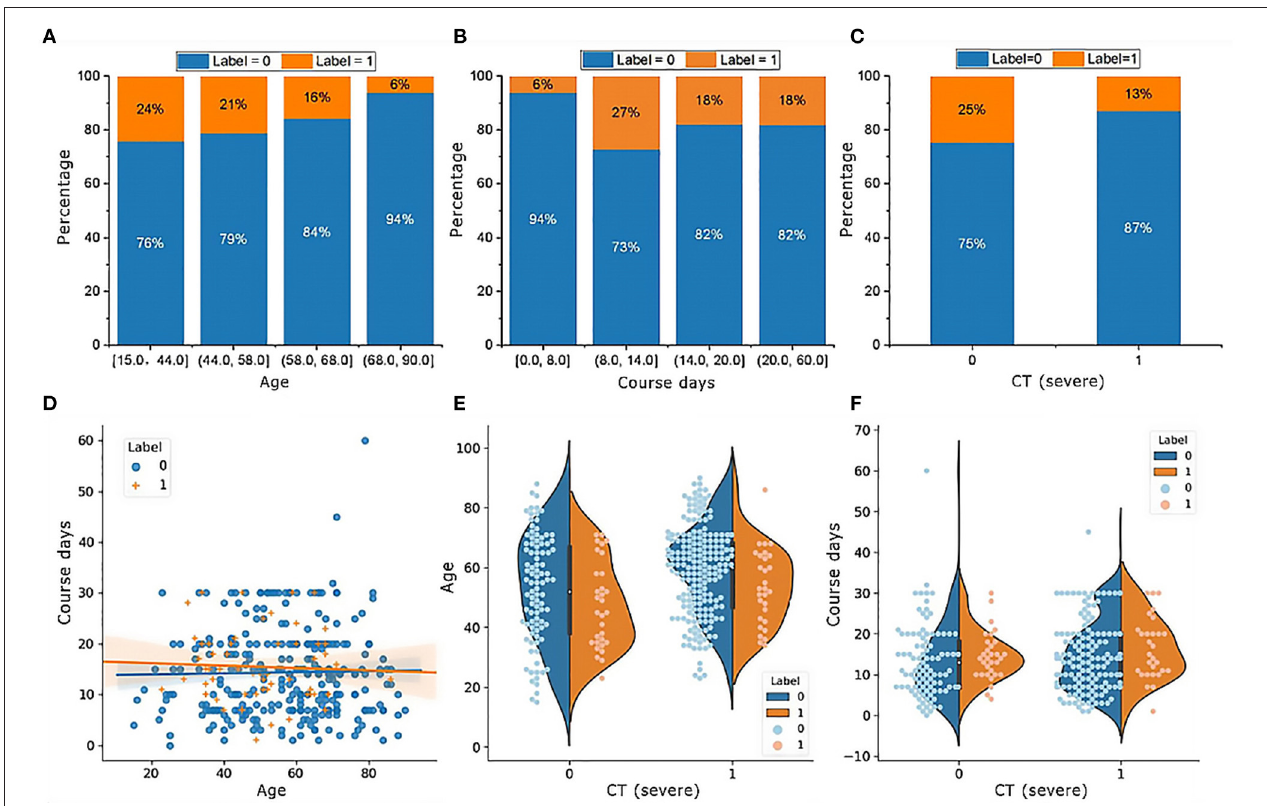
FIGURE 5 | Characteristics of the top three important features in patients with or without positive RT-PCR test results and symptoms after hospital discharge. (A) The percentage of patients in label 1 gradually decreases with increasing age; (B) patients with label 1 account for the smallest portion (6%) of the total patients; (C) patients with label 1 in the group of CT (severe) is 12% smaller than CT (nonsevere); (D) there is no distinct rule in the course of disease for different ages of patients; (E) for patients in the group of CT (nonsevere), the age in label 1 tends to be smaller than label 0, while their course of disease could be longer in (F) .